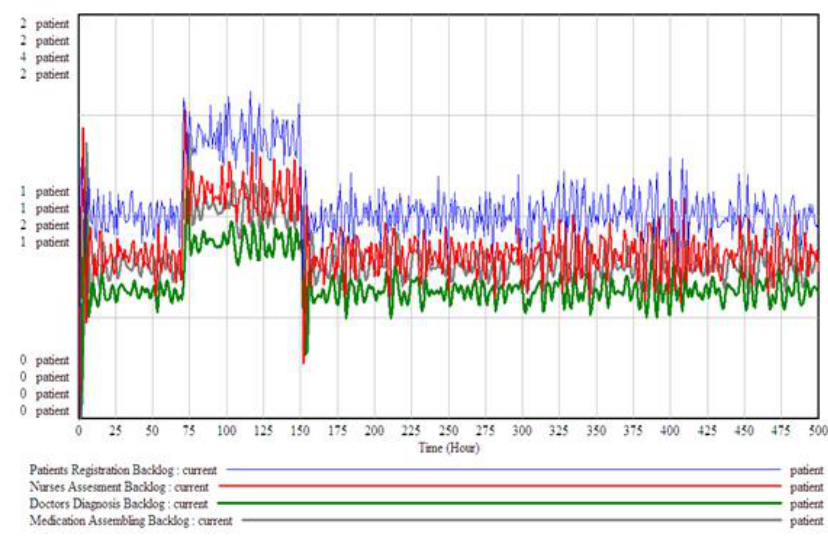
Figure 11. ER’s backlogs